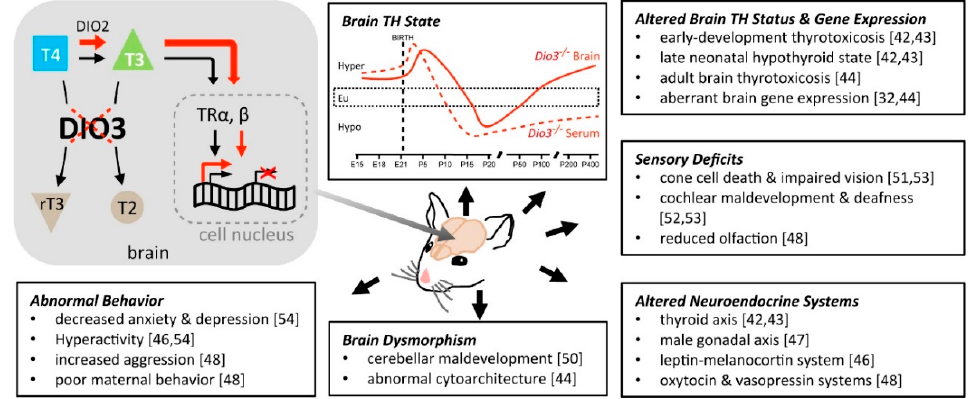
Figure 2. Neurological consequences of DIO3 deficiency in mice. The lack of DIO3 function prevents degradation of THs, increasing their availability and molecular action in the brain (red lines and arrows). Increased T3 action in the brain (grey arrow) leads to multiple neurological phenotypes (black arrows). TR, thyroid receptor; DIO2, type 2 deiodinase.